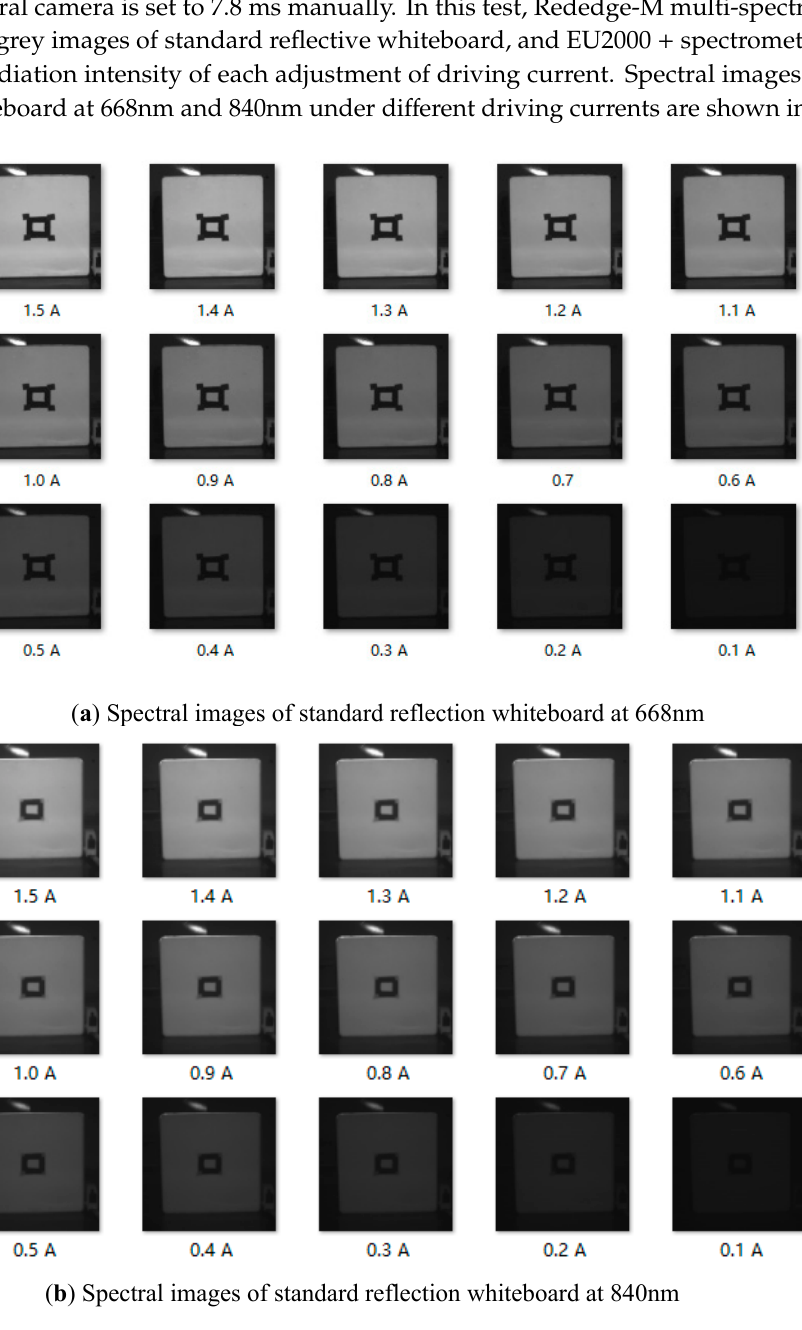
Figure 10. Spectral images of standard reflection whiteboard at 668nm and 840nm under different current drive.